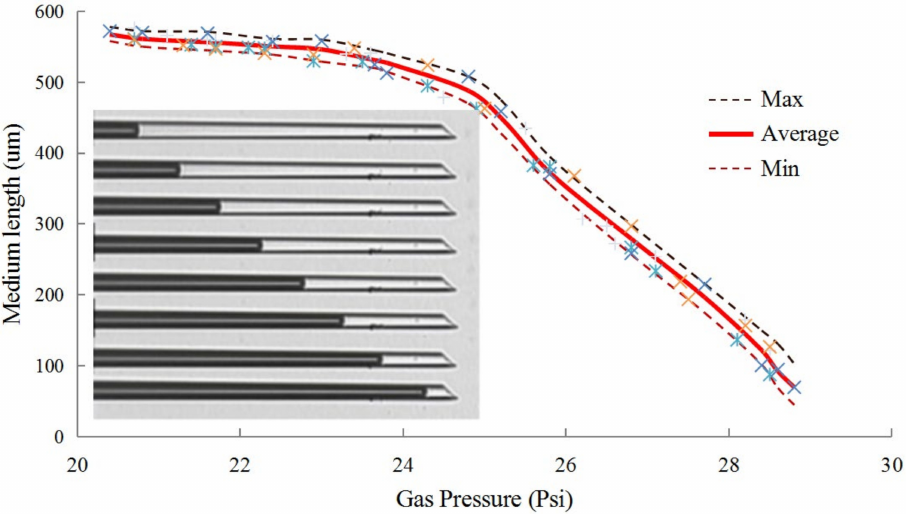
Figure 8. Calibration results between gas pressure and medium culture